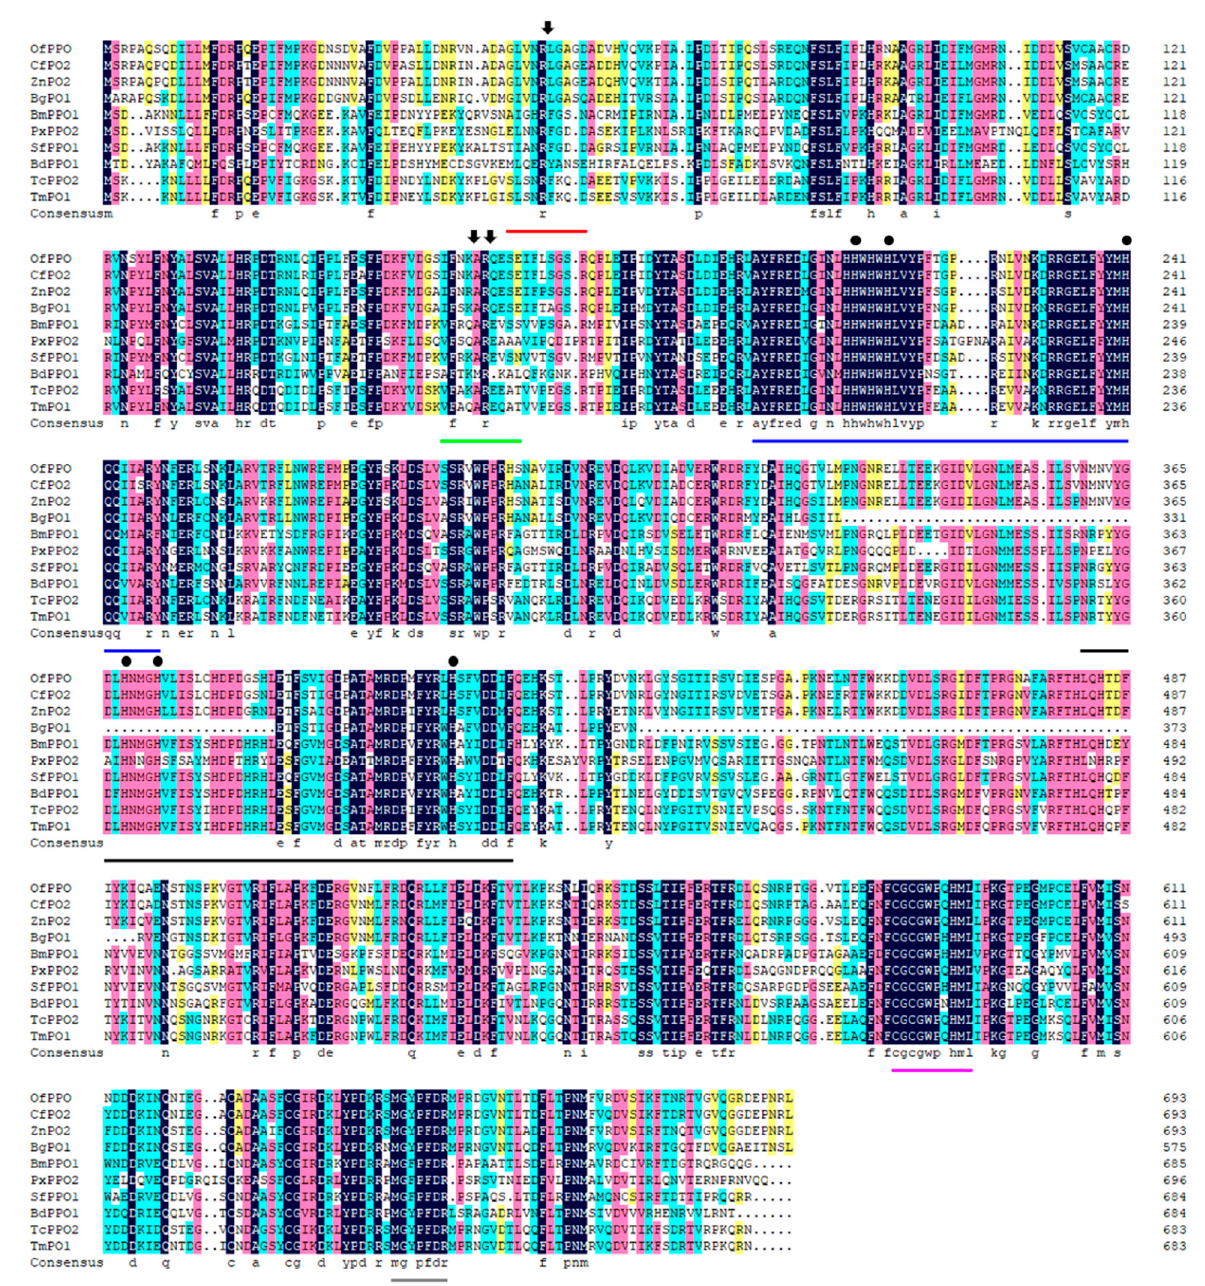
Figure 2. Multiple amino acid sequence alignment of insect PPOs. Protein sequences of from Odon- totermes formosanus PPO (OfPPO), Coptotermes formosanus PO2 (CfPO2, AHB39936.1), Zootermopsis nevadensis PO2 (ZnPO2, XP_021921811.1), Blattella germanica PO1 (BgPO1, PSN38098.1), Bombyx mori PPO1 (BmPPO1, AAG09304), Plutella xyostella PPO2 (PxPPO2, ACS36209.1), Spodoptera frugiperda PPO1 (SfPPO1, ABB92834), Bactrocera dorsalis PPO1 (BdPPO1, AFP81887), Tribolium castaneum PPO2 (TcPPO2, NP_001034522), and Tenebrio madens PO1 (TmPO1, XP_044260894.1) were aligned using DNAMAN. The two potential proteolytic cleavage sites were shown by red and green lines, and the predicted cleavage bonds were marked with black arrows. CuA and CuB were underlined with blue and black lines respectively, and the conserved six histidine residues are marked with black dots. The thiol ester sites and C-terminal conserved motif were underlined with pink and gray lines, re- spectively.